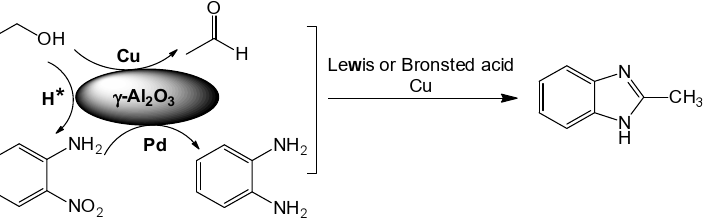
Scheme 52. Mechanism for the direct synthesis of benzimidazole derivatives from